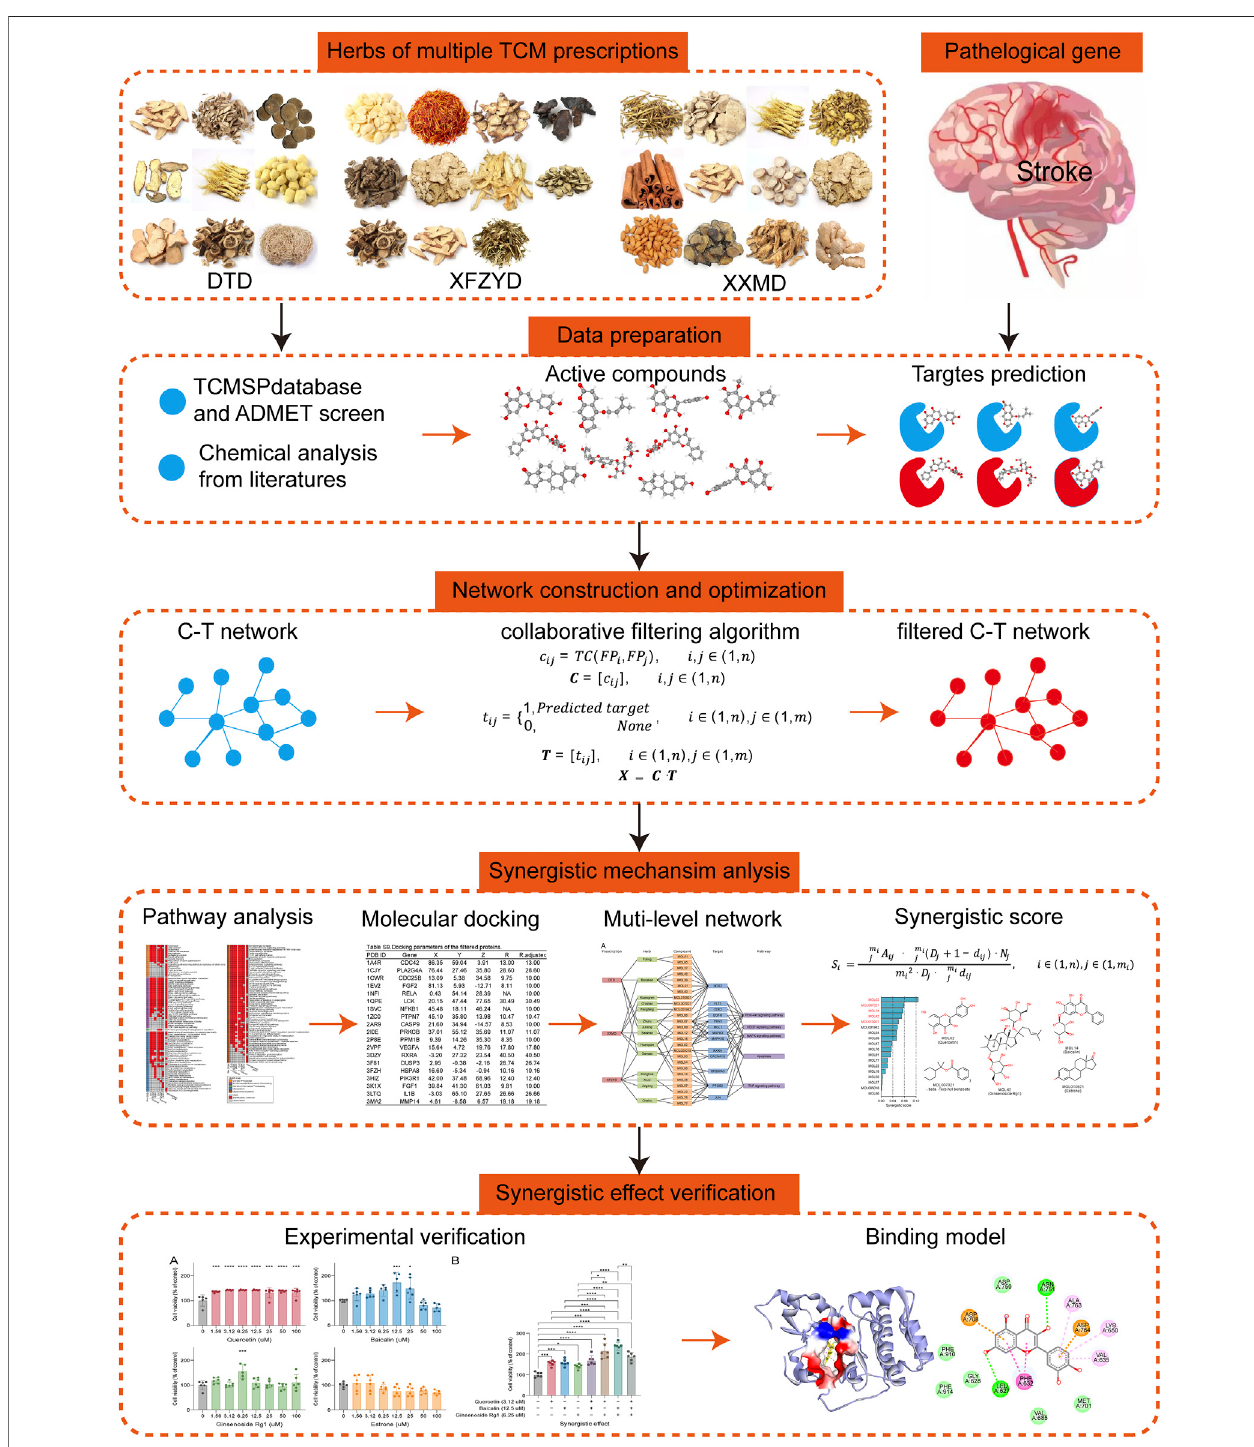
FIGURE 1 | The work fl ow of the analysis for this